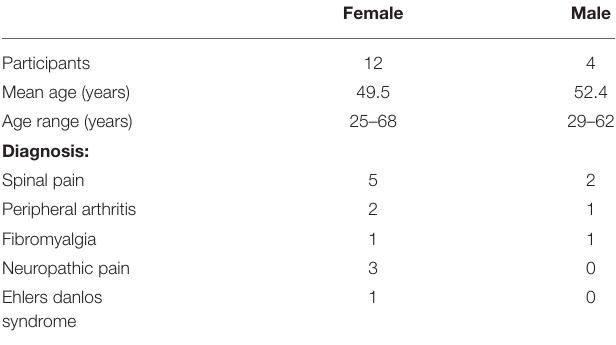
TABLE 2 | Participant